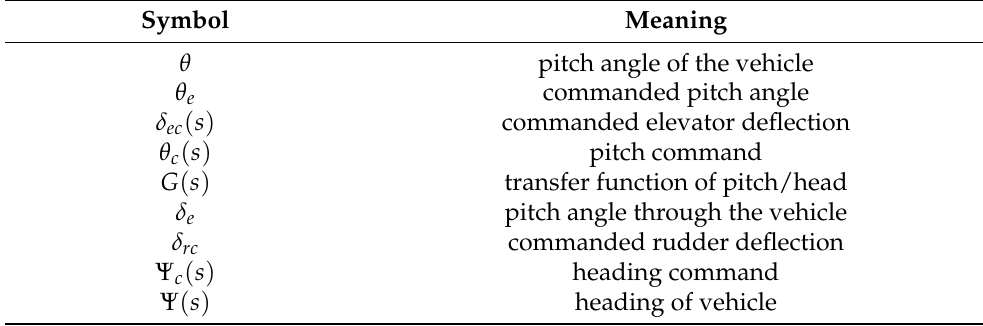
Figure 1. An unmanned submersible vehicle and a general representation of AUV with pitch and head. Table 1. Notations used throughout the